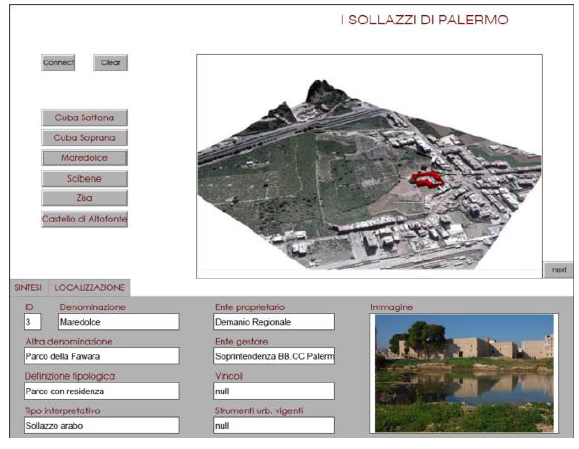
Figure 14. 3D Information system of Maredolce site (Gristina, Scianna,